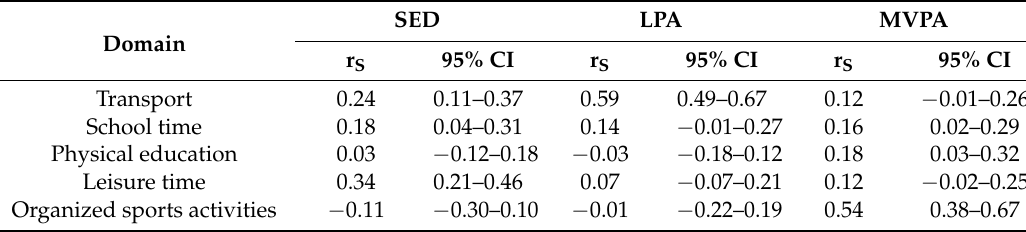
Table 4. Correlation of self-reported and objectively measured PA in different domains in children ( n = 207). SED Domain